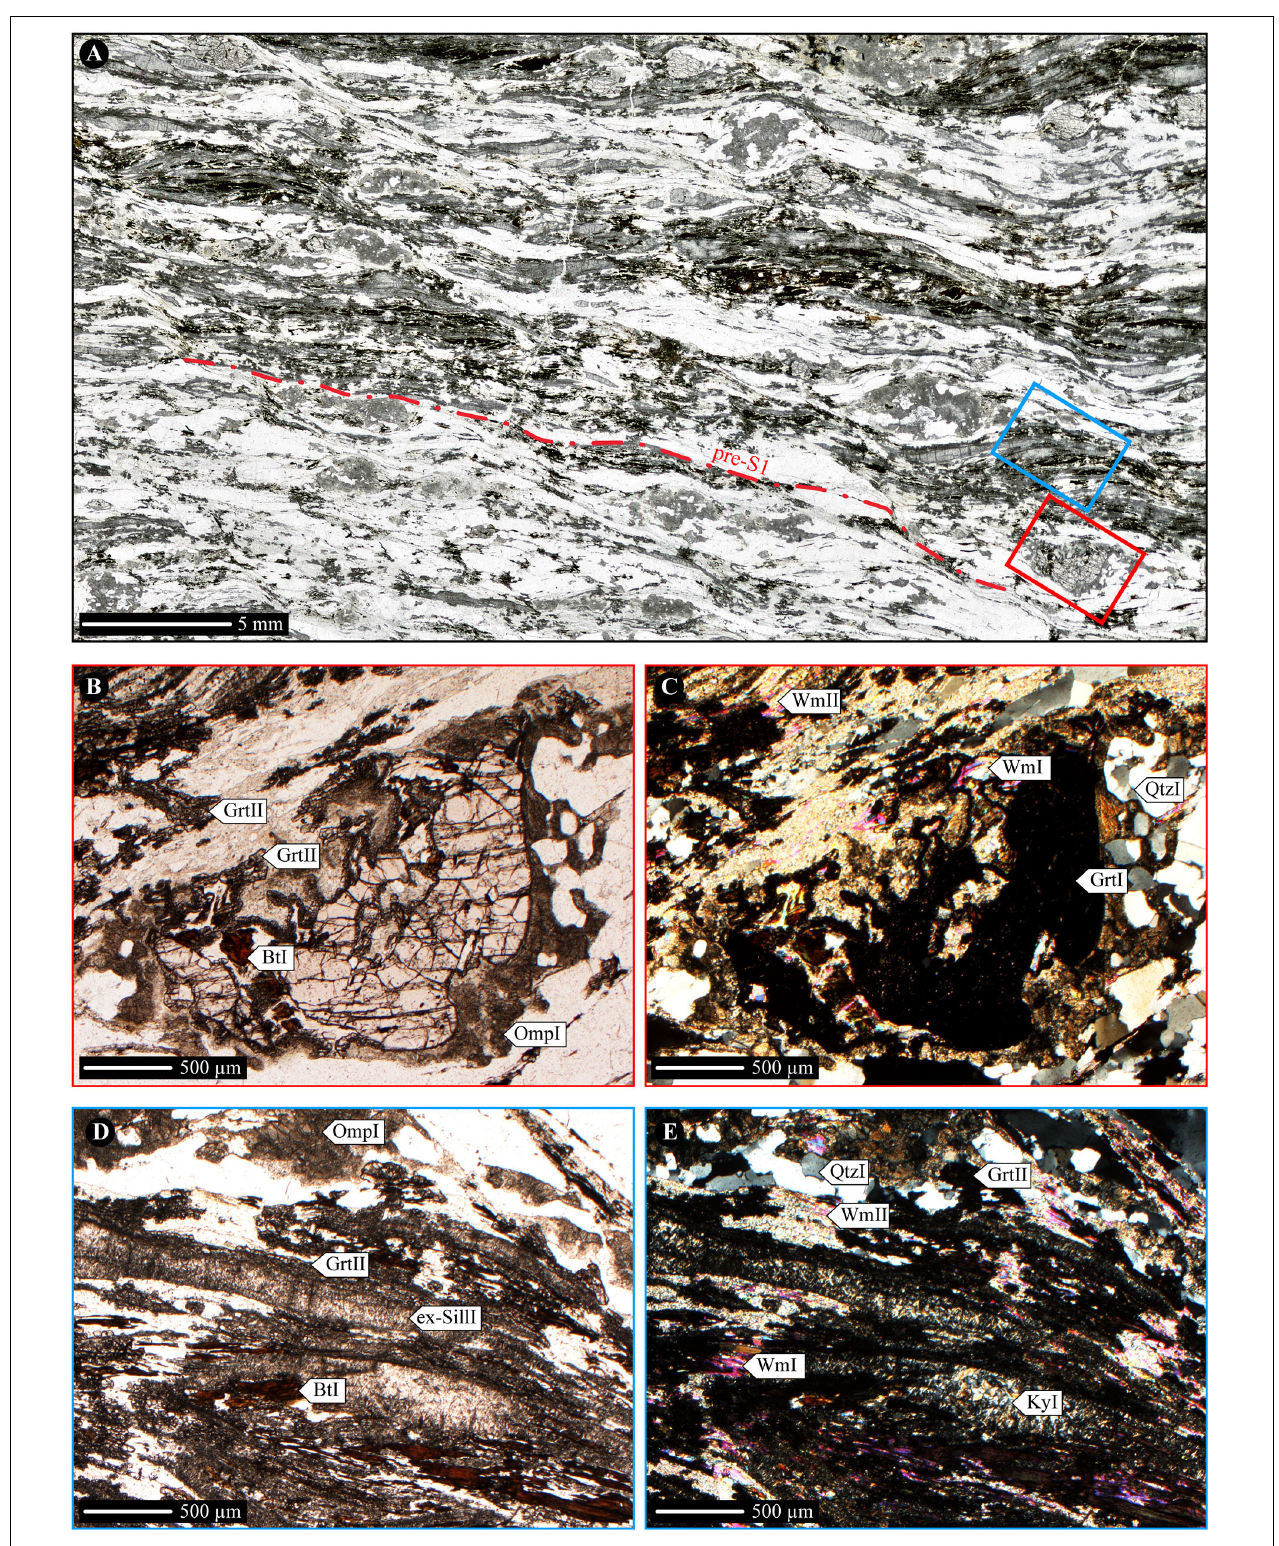
FIGURE 2 | (A) High-resolution optical scan of the entire thin section characterized by well-developed pre-S1 foliation, plane polarized light. (B) pre-alpine Grt microdomains, plane polarized light. (C) pre-alpine Grt microdomains, crossed polars. (D) pre-alpine Sill and Pl microdomains, plane polarized light. (E) pre-alpine Sill and Pl microdomains, crossed